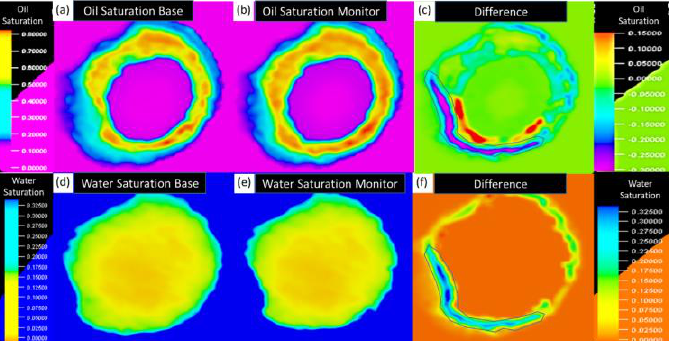
Figure 13. Reservoir performance over time of average saturation. ( a ) Oil saturation baseline 1994, ( b ) oil saturation monitor 2014, ( c ) oil saturation difference, ( d ) water saturation baseline 1994, ( e ) water saturation monitor 2014, and ( f ) water saturation difference. The black polygon shows the significant decrease and increase in oil and water saturation, respectively. Based on what has been shown so far in this study, we can easily relate the pressure changes to the difference in seismic amplitude of the final migrated stack of the baseline and monitor survey when trying to understand the structure of the predicted 4D signal.